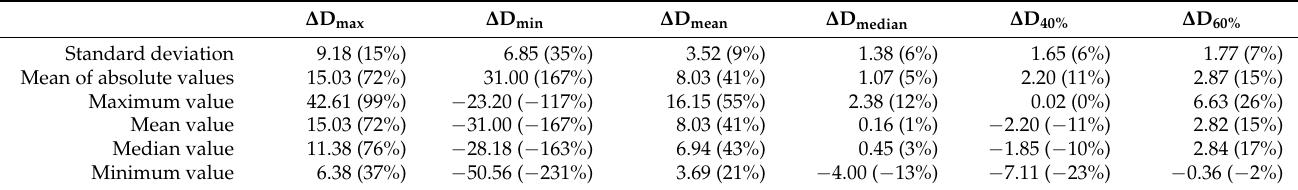
Table 6. The landslide thickness of the prediction minus the observation for 28 occurrence-time- known cases. (Unit: m, % relative to the